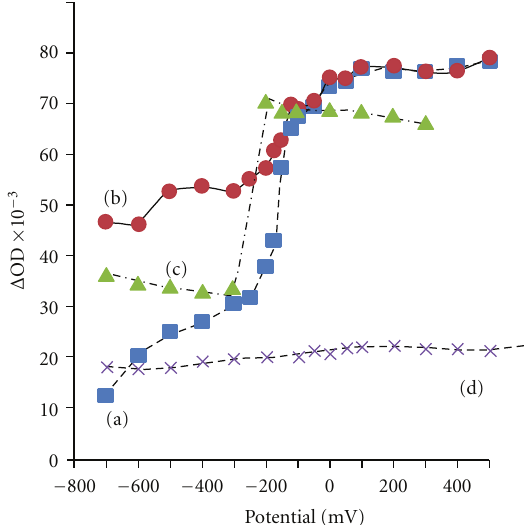
Figure 13: Plot of absorbance at 500 nm versus applied potential for (a) poly-DHI film, (b) Cu-treated poly-DHI film, (c) Fe(III)-treated poly-DHI film, and (d) Fe(II)-treated poly-DHI